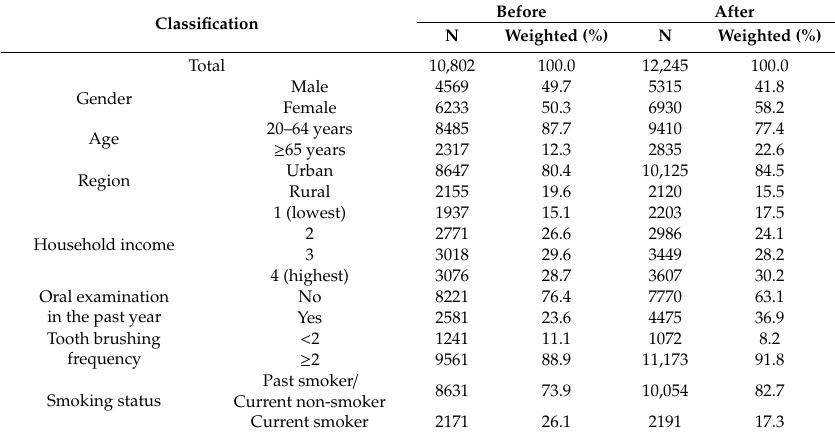
Table 1. Characteristics of